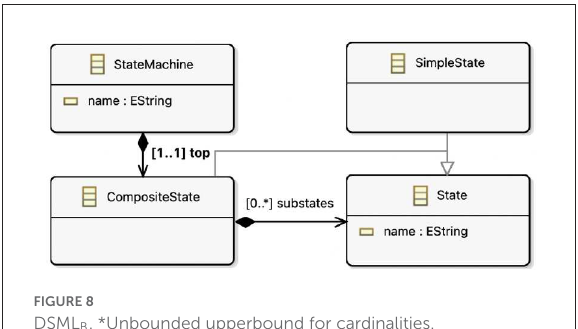
FIGURE8 DSML B . *Unbounded upperbound for